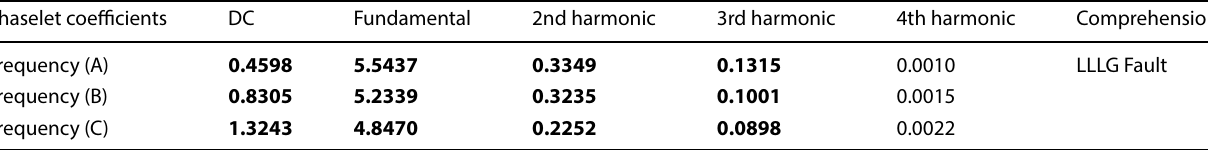
Table 6 Phaselet coefficients under LLLG fault